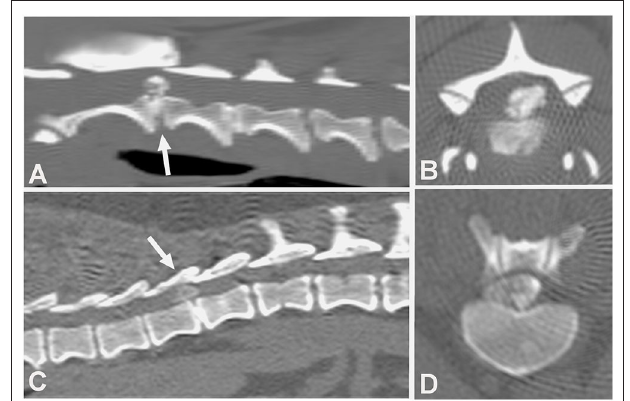
FIGURE 2 | Computed tomographic (CT) images showing the appearance of mineralized intervertebral disc extrusion in the vertebral canal. (A) Sagittal reconstructed non-contrast CT image showing a hyperattenuating mass suggestive of extruded disc material into the vertebral canal between C2-3 (arrow). The intervertebral disc space also mineralization at C2-3. (B) Transverse non-contrast CT image showing a large hyperattenuating mass into the vertebral canal at the intervertebral disc level C2-3. (C) Sagittal reconstructed non-contrast CT image showing hyperattenuating material into the vertebral canal between T1-12 (arrow). (D) Transverse non-contrast CT image showing a large hyperattenuating mass disc extrusion occupying most of the vertebral canal at the intervertebral disc level